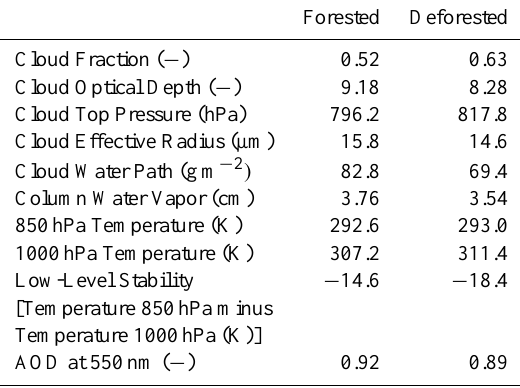
Table 1. Average warm cloud, aerosol, and atmospheric profile statistics for both forested and deforested land in our study region. The averaging period is for August through October for the years 2004 through